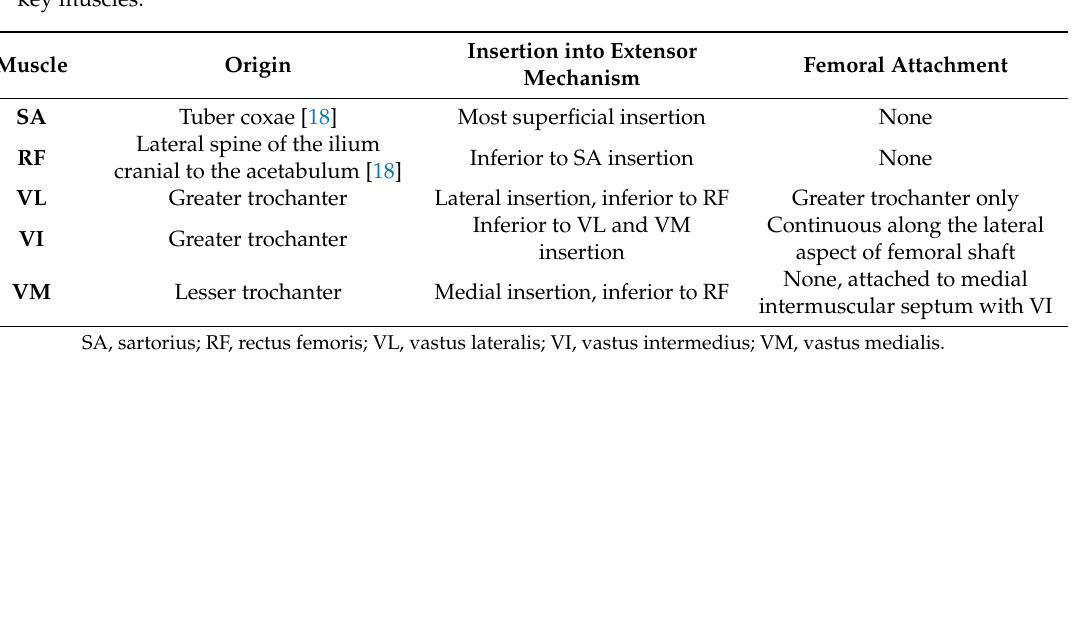
Table 2. Regions of origin, knee extensor mechanism insertion points and femoral attachment of the key